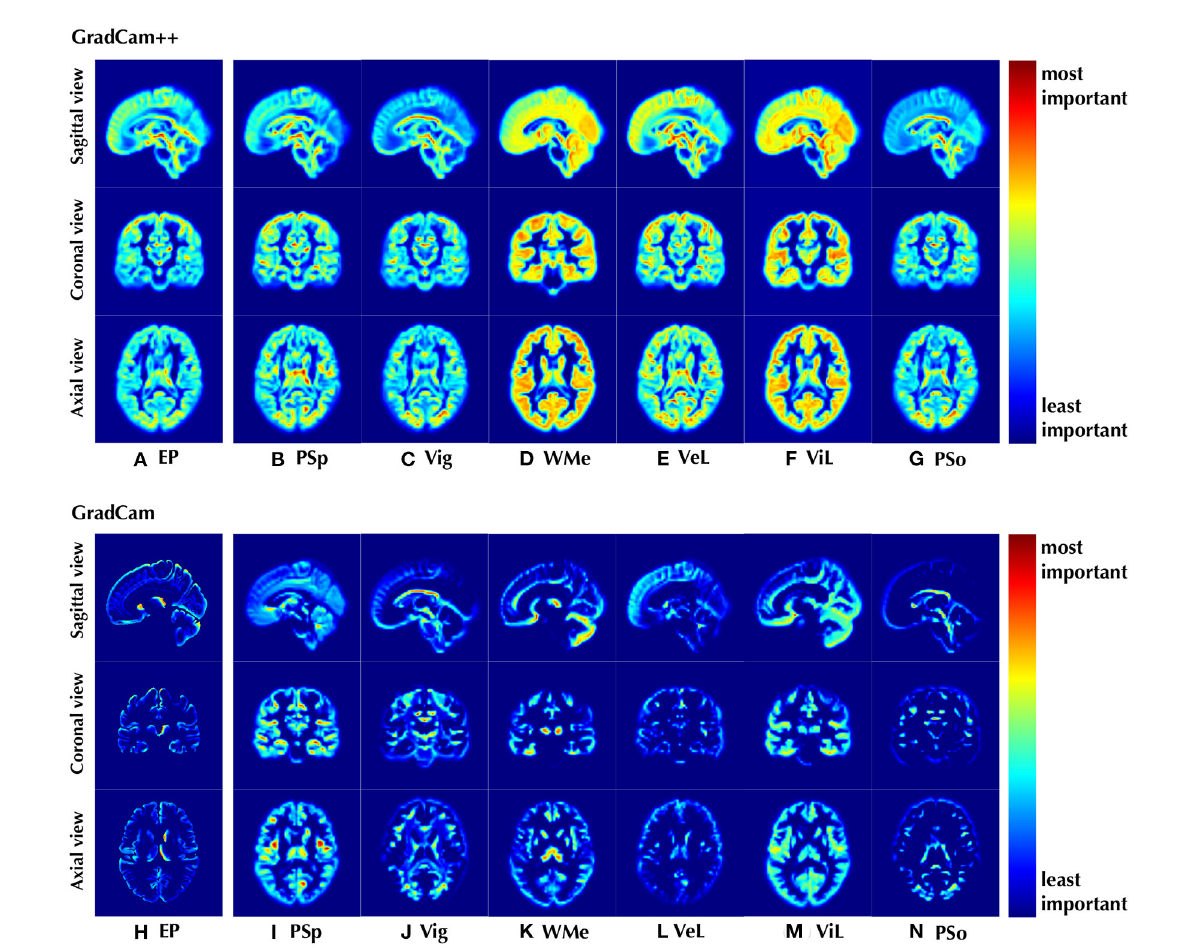
FIGURE4 Visualization of the discriminative positions identified by the proposed model on (A, H) EP classification and (B–G, I–N) CLC tasks with attentional weights. The results were shown as the mean of all cases in the data set. We used both WM and GM images as input and n was set to two for